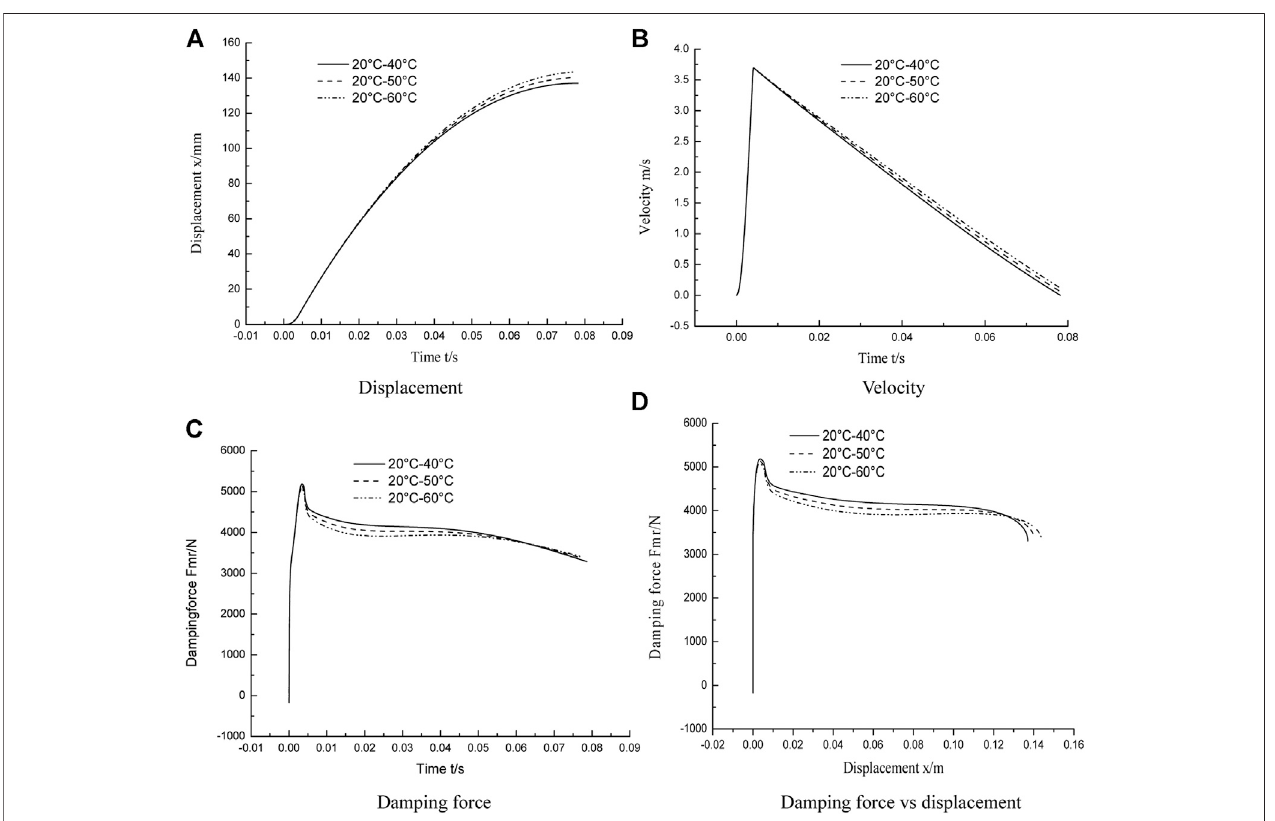
FIGURE 15 | Simulation results of MR impact buffer system under CTSMC control strategy. (A) Displacement. (B) Velocity. (C) Damping force. (D) Damping force vs.